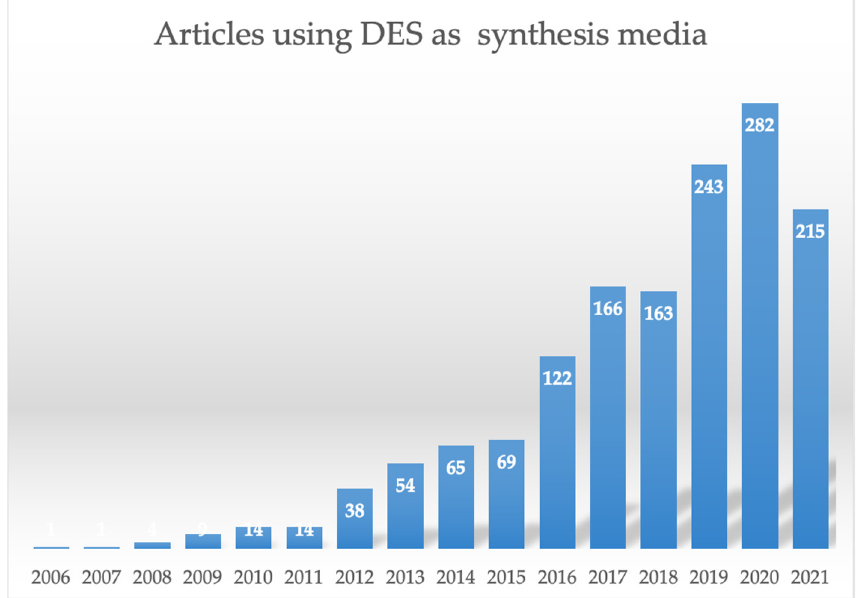
Figure 3. Manuscripts in which DESs have been used as synthesis media from 2006 to 20 October 2021. Source: Web of Science.